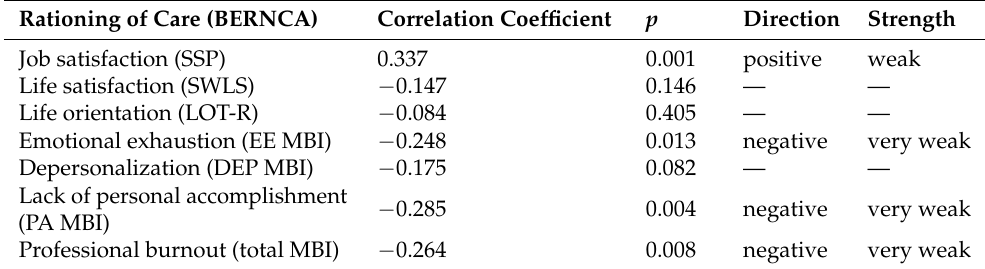
Table 7. The correlations of the BERNCA scores with other